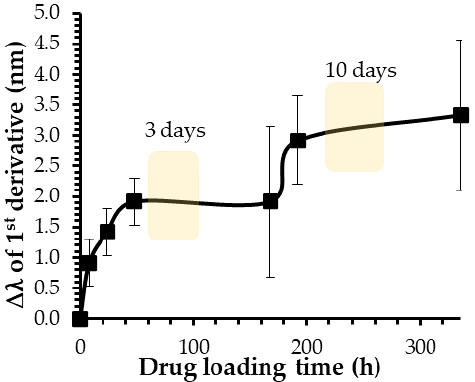
Figure 3. Drug-loading kinetics of ketorolac in AuNPs at the AuNP-to-ketorolac ratio of 1:100. Ketorolac and flurbiprofen release experiments were then performed at the four dif- ferent ratios with the two loading times of 3 and 10 days (Figure 2c,d). A comparison of the drug release percentages observed in these conditions shows that the loading time did not have a significant impact on the data. Indeed, the ketorolac release percentages were quite similar for all ratios studied with values of (24.9 ± 4.0)%, (25.1 ± 5.8)%, (25.7 ± 6.7)%, and (25.8 ± 6.6)% for a 10-day loading time at the ratios 1:10, 1:20, 1:50, and 1:100, respec- tively (Figure 2c). Regarding the experiments with flurbiprofen, values of (19.6 ± 0.8)%, (16.9 ± 1.3)%, (17.1 ± 0.9)%, and (18.0 ± 0.3)% were observed for a 10-day loading time at the ratios ranging from 1:10 to 1:100. Despite slightly higher values observed for the 1:10 and 1:100 ratios with a 10-day loading time, these differences were not substantial enough to justify an additional 7 days of drug loading when this study was contextualized in the biomedical field, in search of an optimized pharmaceutical formulation. Considering these results, a second shift in the plasmon band peak could be induced by a reorganiza- tion of molecules in the polymeric crown stabilizing the gold core, instead of a second loading phase. Indeed, the modification of the chemical environment near the gold core could simply be explained by the displacement of the already-loaded drug molecules. Furthermore, because there was no significant difference in the drug release for flurbi- profen and ketorolac when a 3-day or a 10-day loading was chosen, all drug release results detailed in following sections were performed with this specific 3-day loading time. It is worth noting that all the experiments were still completed with a 10-day loading time and the results can be found in the Supplementary Information (Figure S4). 2.2. Influence of AuNPs-Related Parameters on the Drug Release After studying the impact of different drug-related parameters on the release of ke- torolac and flurbiprofen, the influence of the AuNPs themselves needs to be addressed. For this purpose, the drug release profiles of free molecules of flurbiprofen and ketorolac were compared to those observed in the presence of AuNPs. In the absence of AuNPs (ketorolac control), the release concentrations were (4.2 ± 0.3) µg/mL, (5.4 ± 0.5) µg/mL, (10 ± 2) µg/mL, and (16 ± 2) µg/mL with ratios ranging from 1:10 to 1:100 (Figure 4a). Regarding the flurbiprofen, the release concentrations were (3.0 ± 0.5) µg/mL, (3.6 ± 0.4) µg/mL, (6.0 ± 0.3) µg/mL, and (9.2 ± 0.6) µg/mL with ratios ranging from 1:10 to 1:100 (Figure 4c). In all cases, the drug concentrations in the dialysate were higher when the drugs were not encapsulated, suggesting that the AuNPs efficiently loaded both mol- ecules and seemed to retain various amounts of ketorolac and flurbiprofen. The same could not be said when the free molecules were dispatched in the dialysate; the drug per- centages in the dialysate were steadily decreasing whilst the initial drug concentration present in the dialysis bag increased. The same experiment was performed with all drugs loaded for 10 days, leading to the same trends (Figure S4).